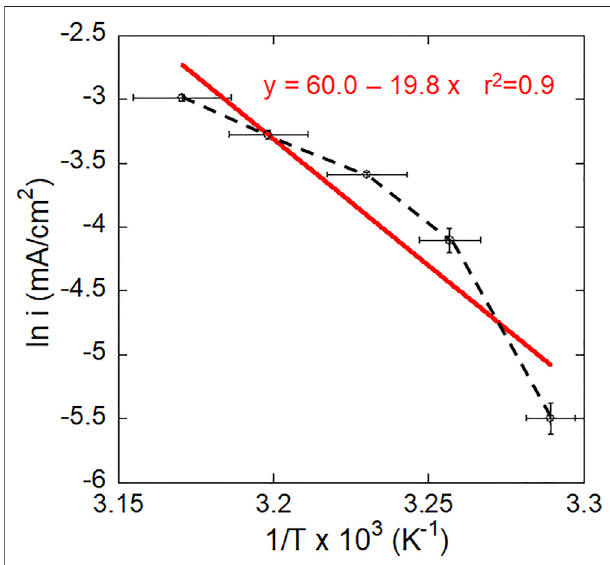
FIGURE 6 | A plot of steady state current at − 510 mV vs. SCE vs. temperature for mirror-polished Ti6Al4V in 2 M HCl. The red line shows the fi tted linear Arrhenius